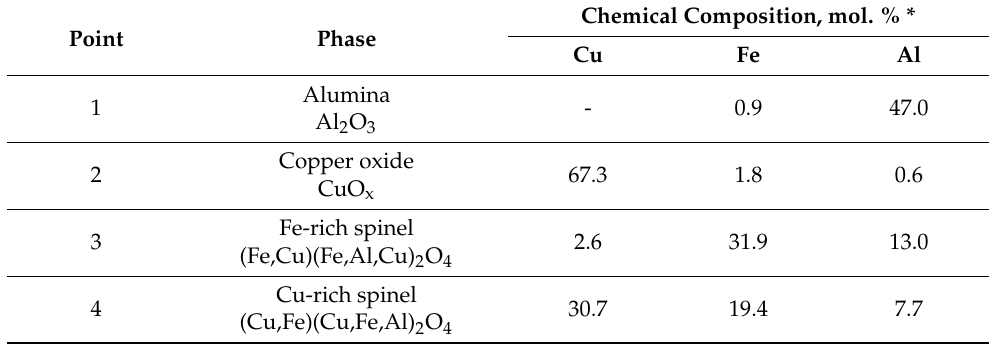
Table 1. EDS analysis of microareas of high-temperature ceramic material corresponding to Figure 2. Chemical Composition, mol. % Point Phase